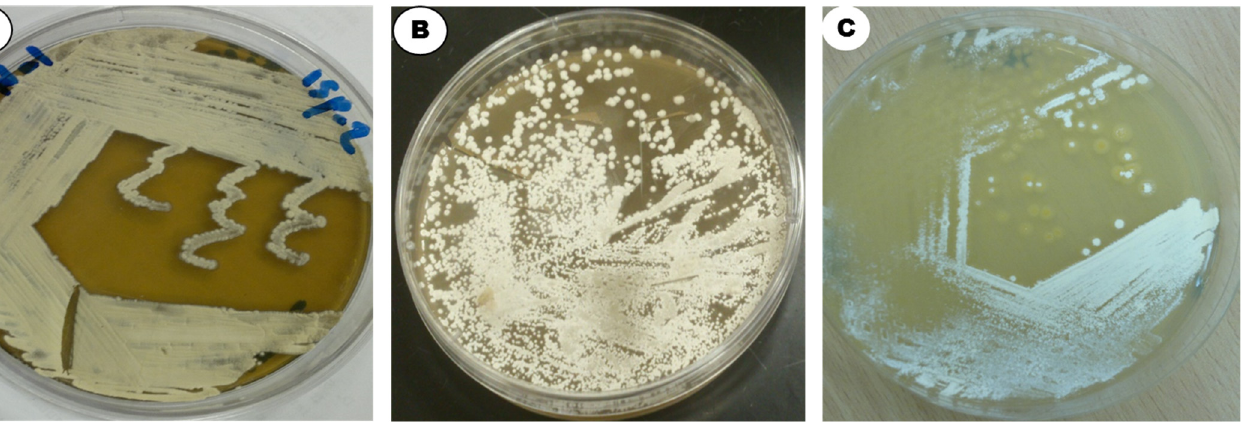
Figure 2. Morphology of Streptomyces sp. strain ess_amH1 in different media: ( A ) ISP-2 medium; ( B ) ISP-4 medium; ( C ) starch casein agar.